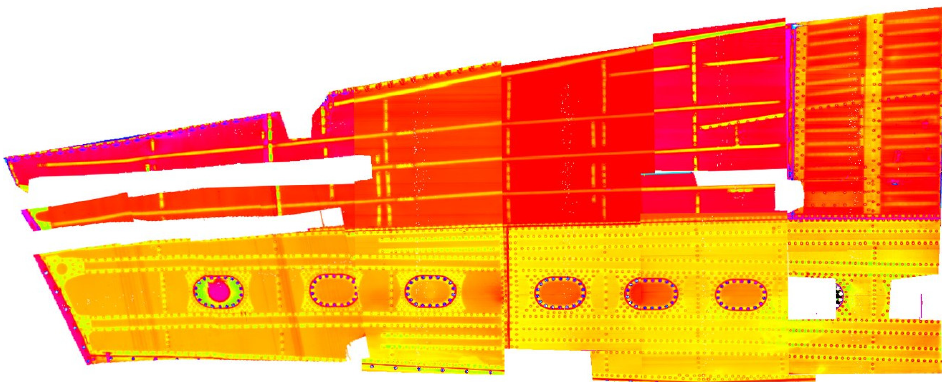
Figure 1. Eddy current scan of the wing structure.